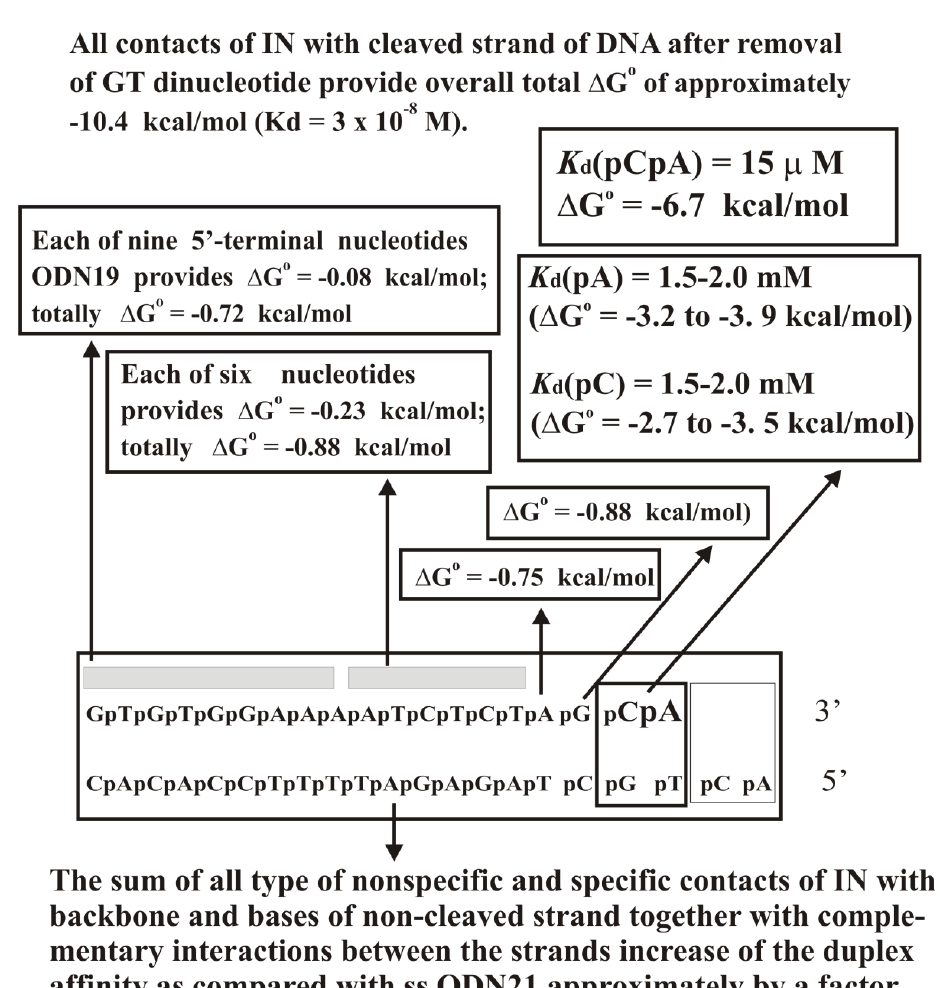
Figure 13. Thermodynamic model of HIV-1 IN interaction of with cognate ds GT-ODN 21 contain- ing 3’-terminal-specific GT dinucleotide.  G° values characterizing different contacts between the enzyme and DNA strands are shown [95].